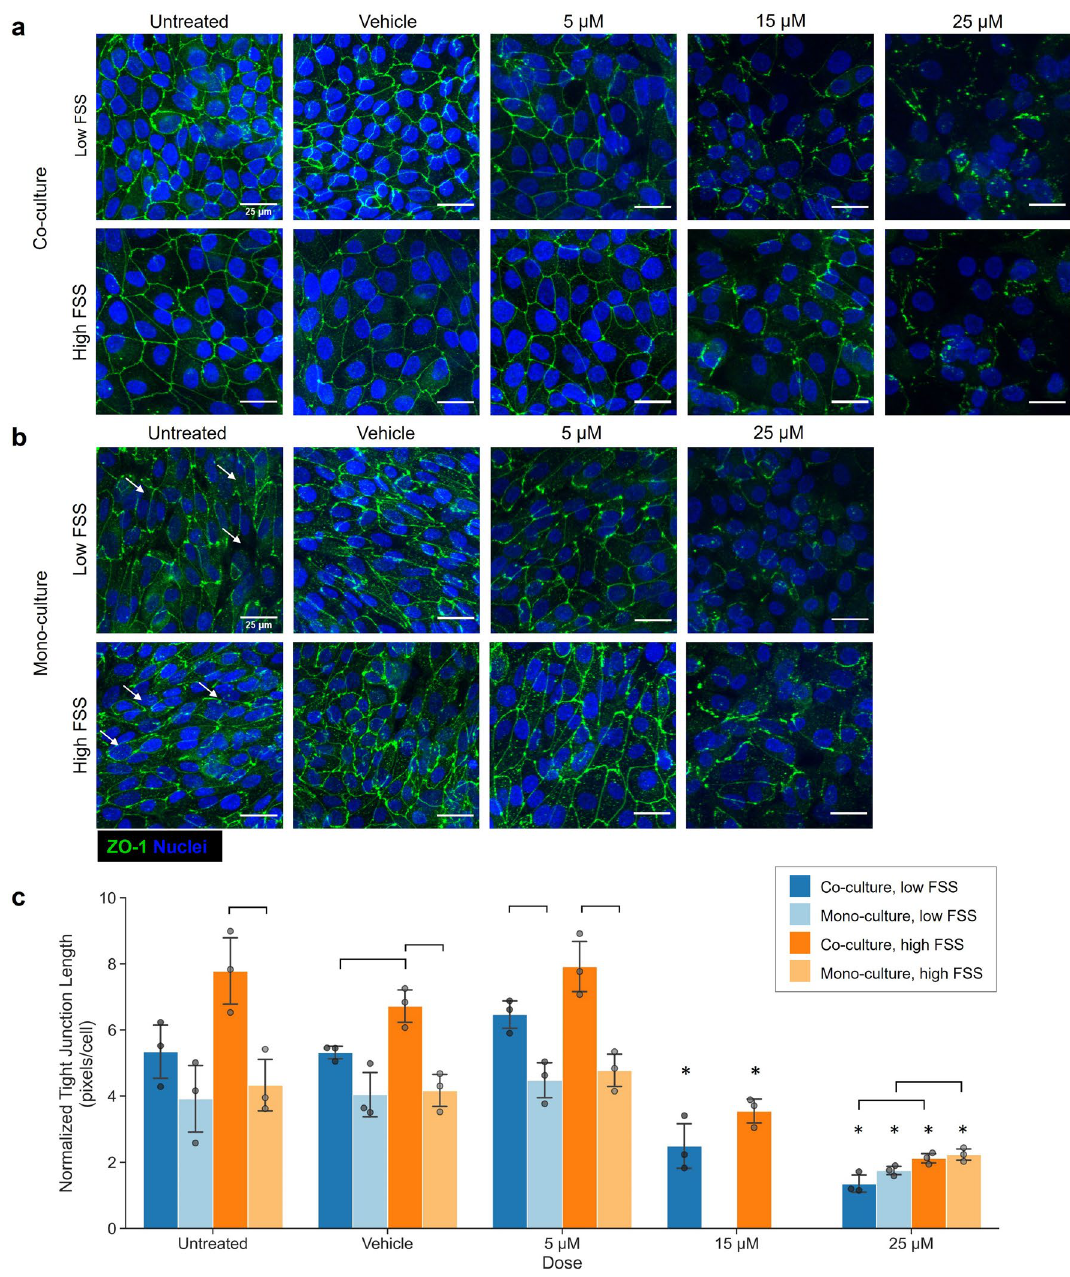
Figure 4. PT model displays dose-dependent loss of tight junctions after exposure to cisplatin. Representative images of hRPTEC tight junction morphology with respect to cisplatin concentration for ( a ) co-cultures and ( b ) mono-cultures after 72 h of exposure. Images are maximum intensity projections of confocal z-stacks of hRPTEC on the device membrane stained for ZO-1 (green) and nuclei (blue). White arrows indicate locations of missing tight junctions in untreated mono-cultures. ( c ) Normalized tight junction length (pixel length of junctions divided by total cells) corroborated that junctional coverage tended to be lower in mono-cultures than in co-cultures at a given FSS. Normalized tight junction length was reduced after exposure to 15 or 25 μM cisplatin. N = 3 devices per condition (biological replicates), where each data point is an average of three equally- sized fields of view per device. Bars represent mean ± SD of biological replicates. * p ≤ 0.05 single-factor ANOVA with Tukey’s post-hoc test relative to corresponding untreated control. Brackets indicate significant comparisons ( p ≤ 0.05) based on two-sided Students’ t